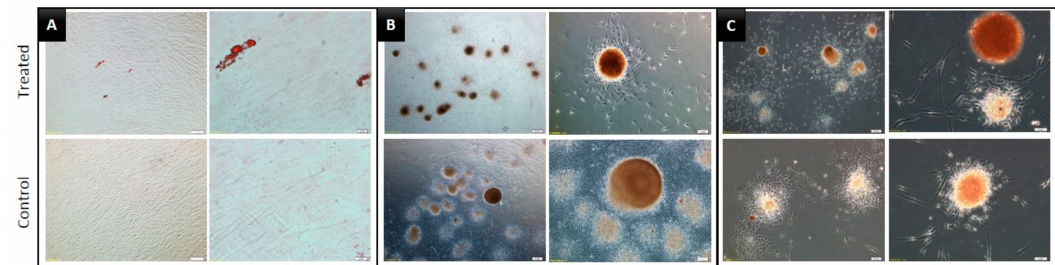
Figure 5. Images of DPSCs induced to undergo adipogenic di ff erentiation for 28 days and stained with Oil Red O. ( A ) 2D, ( B ) SF, and ( C ) ULA group,